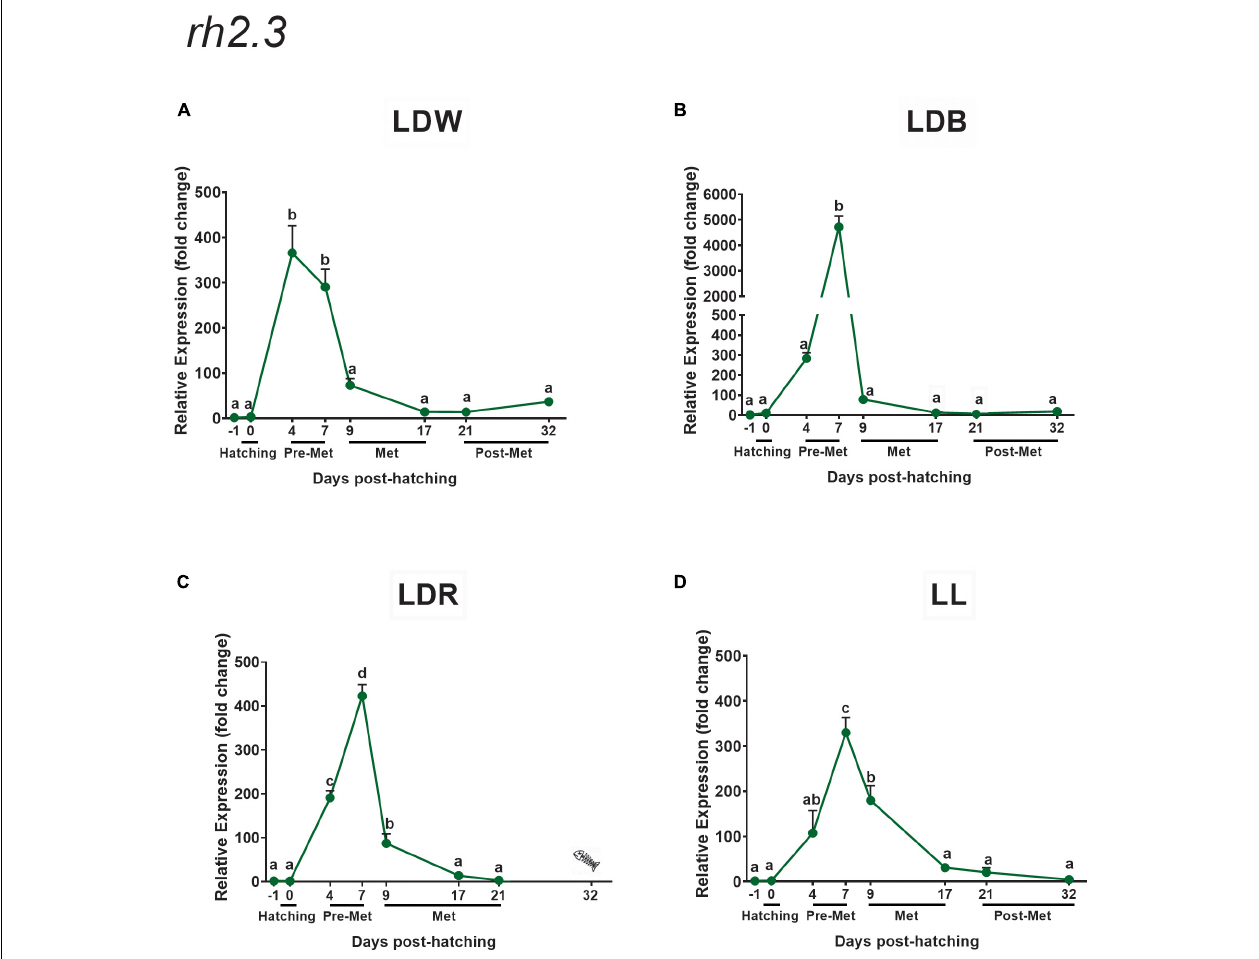
FIGURE 7 | Expression of green cone opsin ( rh2.3 ) in embryos, larvae, and juveniles of the Senegalese sole on dph –1 (embryos), dph 0 (hatching), dph 4–7 (pre-metamorphosis, Pre-Met), dph 9–17 (metamorphosis, Met), and dph 21–32 (post-metamorphosis, Post-Met) analysed by RT-qPCR. For further information, see the legend in Figure 1